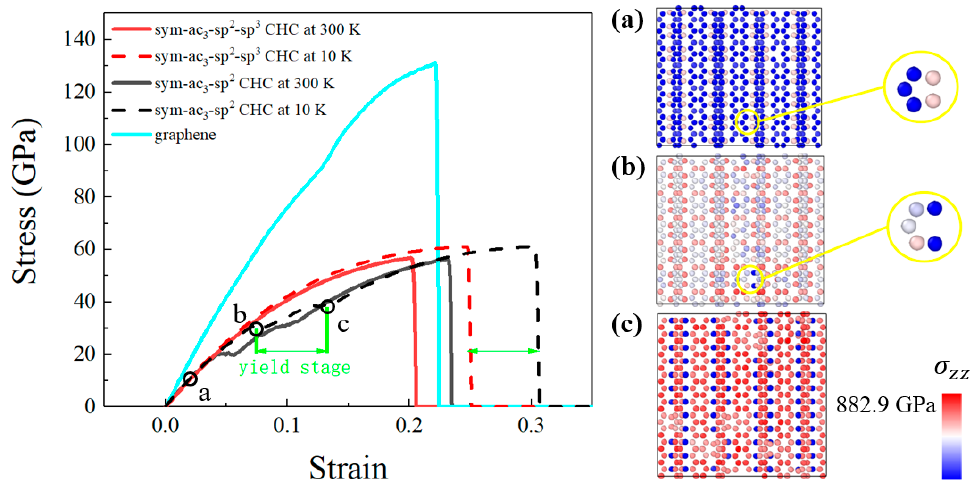
Figure 4. Stress–strain curves of the sym-ac 3 –sp 2 –sp 3 CHC and sym-ac 3 –sp 2 CHC. There are three characteristic points representing three different stress states, and corresponding snapshots display